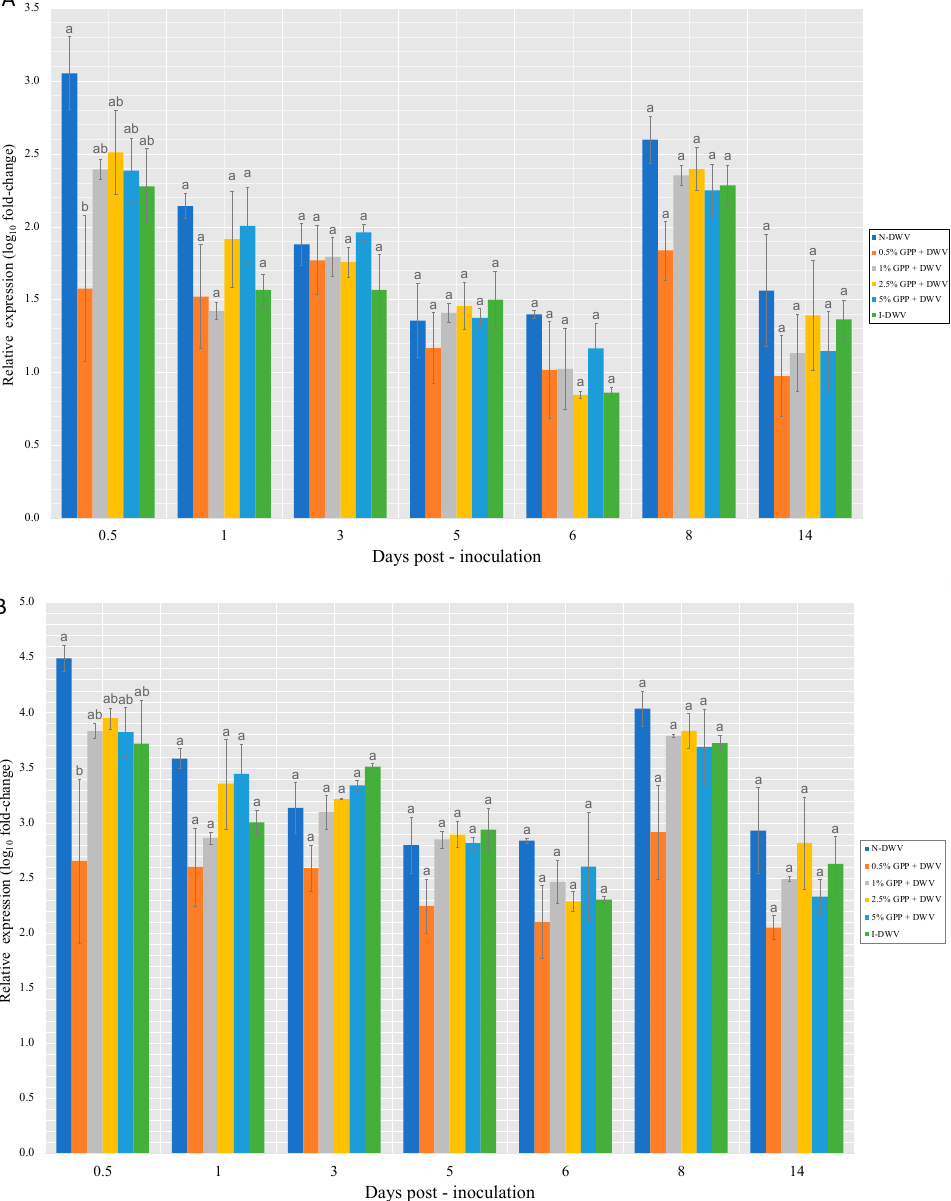
Figure 4. Expression level of Dicer ( A ) and Argo-2 ( B ) genes involved in the RNAi-pathway in worker honeybees per collection throughout the assay. Grape pomace powder (GPP) concentrations (0.5, 1, 2.5 and 5%), inoculated control (I-DWV), and non-inoculated control (N-DWV) are shown in different colors. Different letters indicate significant differences according to Tukey’s test ( p < 0.005).